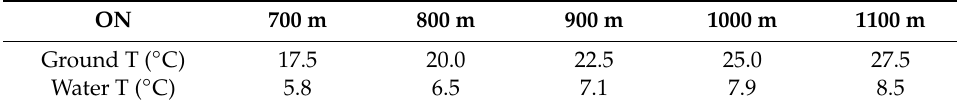
Table 7. Ontario ground and water temperature at depth.